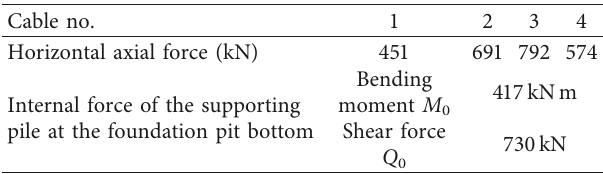
Table 3: Axial force of anchor cable and internal force of sup- porting pile at the foundation pit bottom. Cable